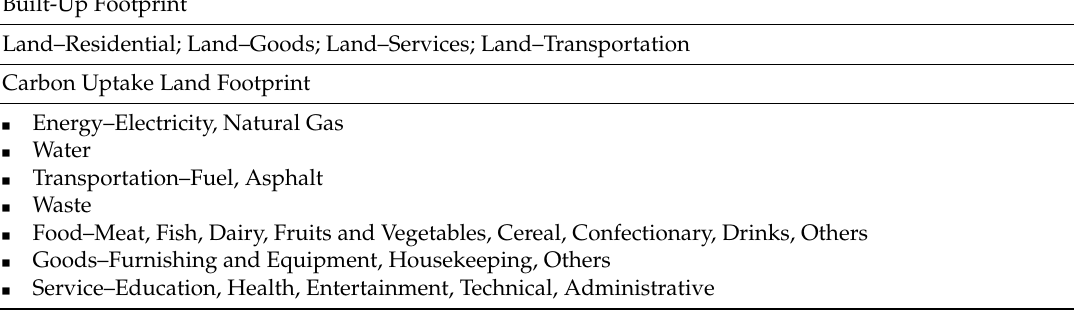
Figure 2. Schematic Diagram of Methodological Approaches.